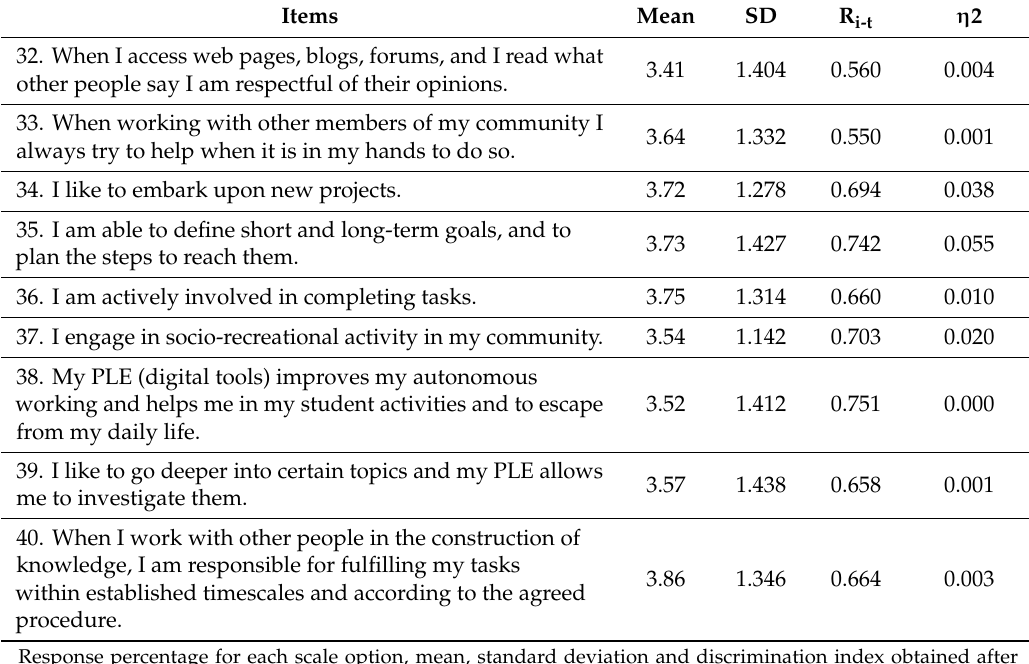
Items Mean SD R i-t η